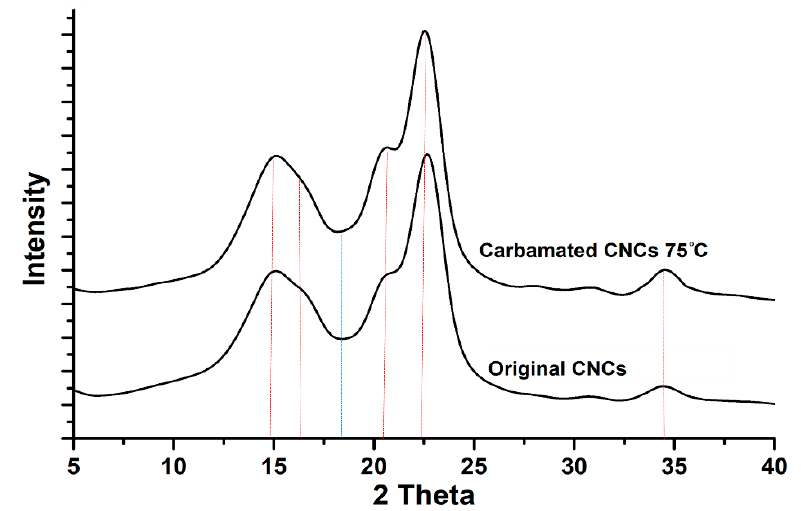
Figure 5. The crystalline structure of the CNCs before and after carbamation at 75 °C using a TDI/CNCs molar ratio of 1.